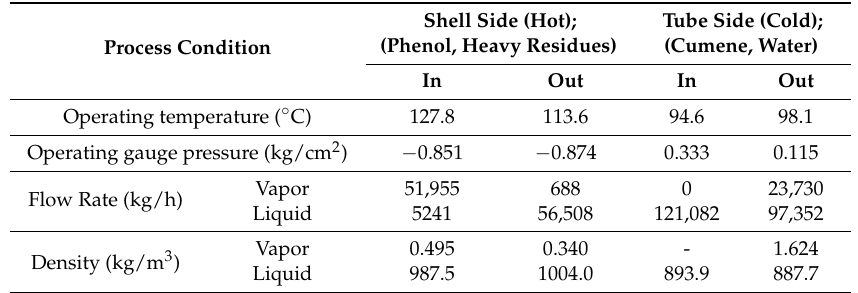
Table 7. Operating condition of overhead